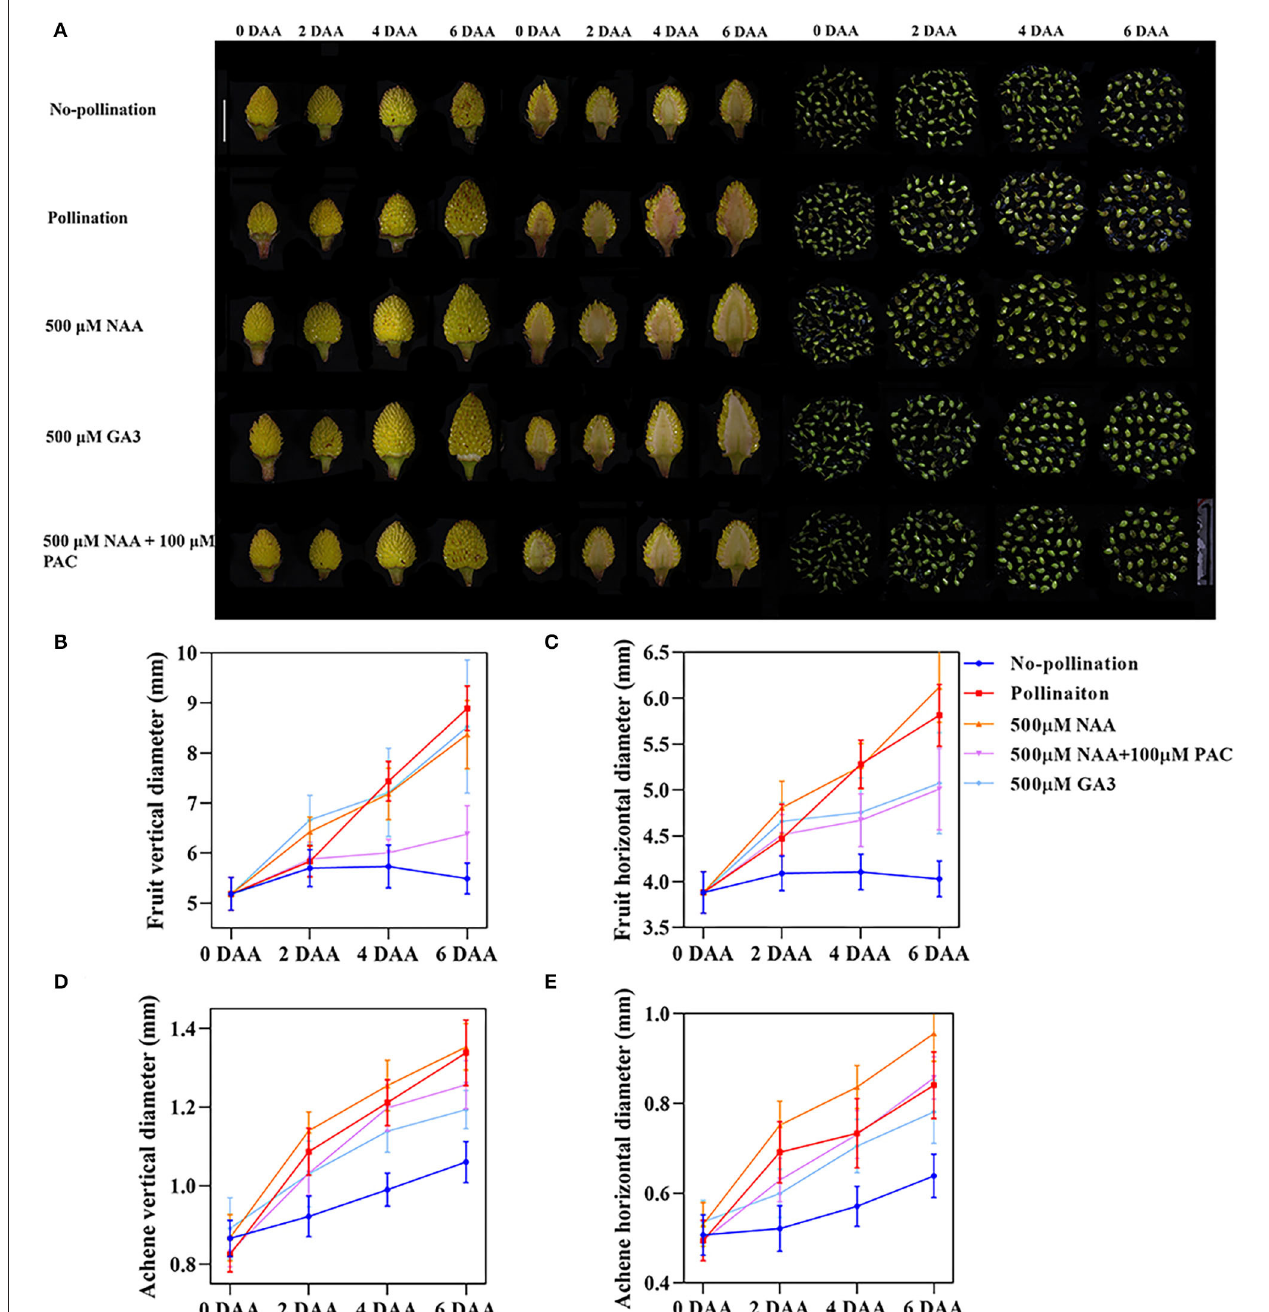
FIGURE 2 | Auxin induced the rapid fruit initiation partially dependent on gibberellin. (A) Development of fruit and achene at different stages under varies growth conditions. Scale bar = 1cm. (B,C) Vertical (B) and horizontal (C) diameters of fruit under varies treatments. Error bar represents SD, n = 15–20. (D,E) Vertical (D) and horizontal (E) diameters of achenes under various treatments. Error bar represents SD, n = 60.